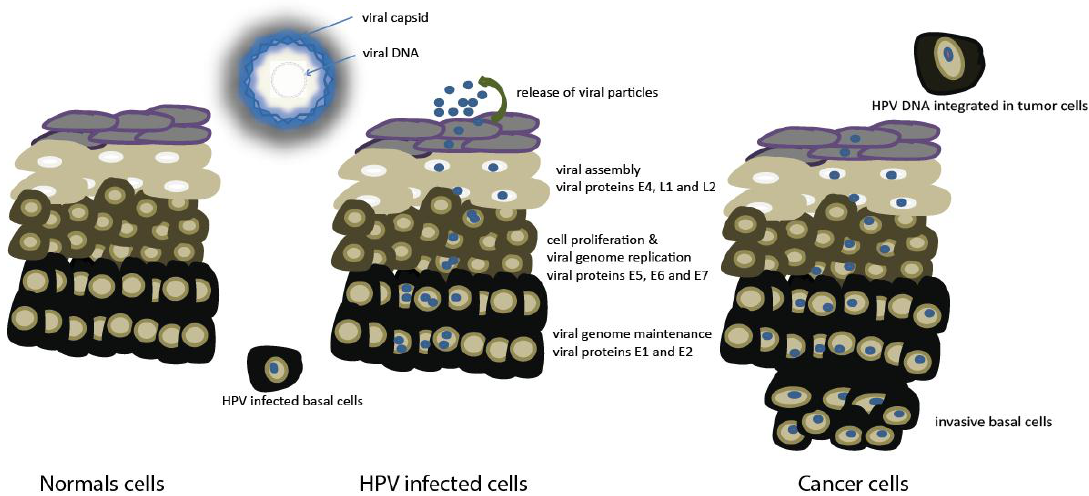
Figure 1. A short overview of HPV infection in cells.